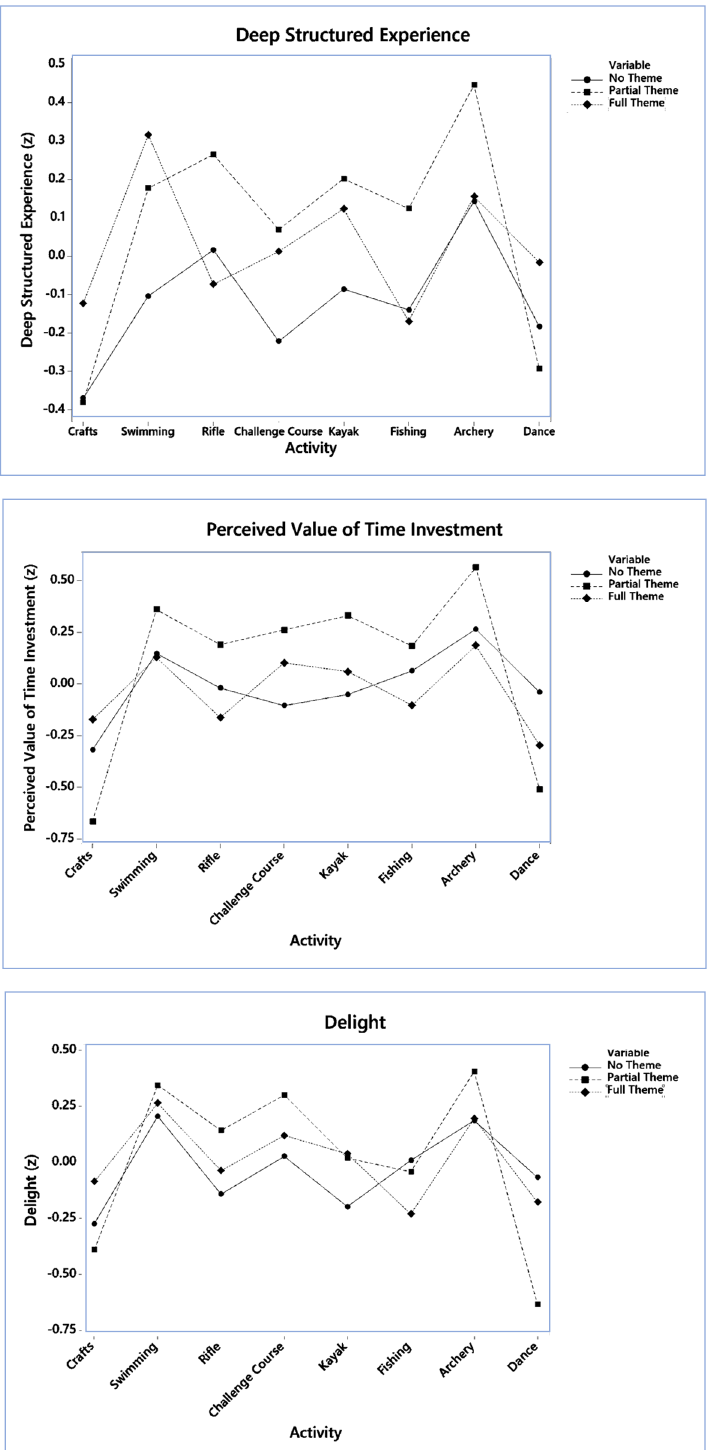
Figure 3. Interaction Effect of Theme by Activity on (a) Deep Structured Experience, (b) Perceived Value, and (c)